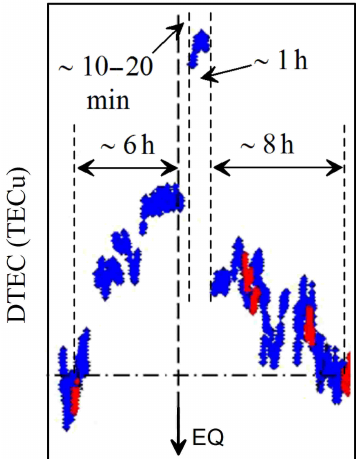
Figure 3. Enlarged view of the hump-like DTEC shape during 5– 6 April 2009 (adapted from Nenovski et al., 2015, their Fig. 10b). Red DTEC values are from GPS satellites with elevation angles EL > 86 ◦ (see Nenovski et al., 2015, for details). EQ identifies the 6 April 2009 main shock.